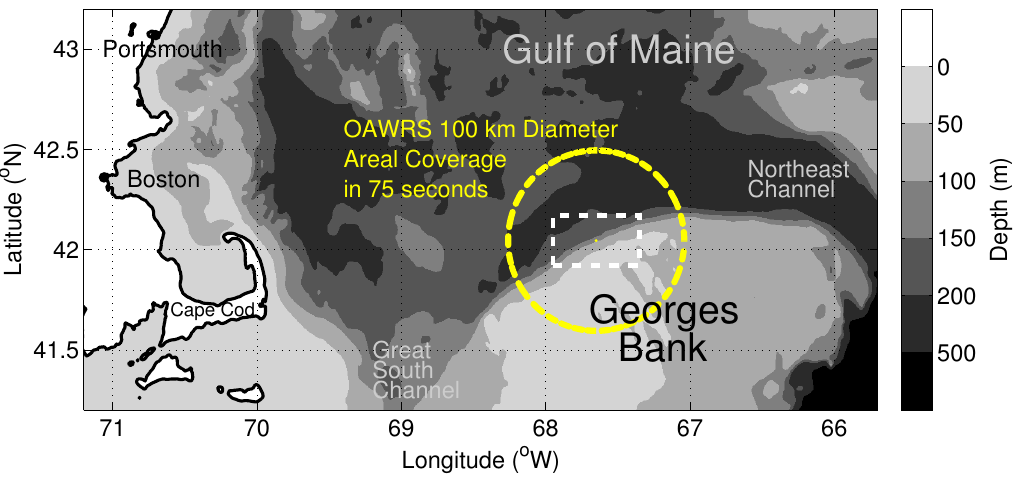
Figure 1. Location of the Ocean Acoustic Waveguide Remote Sensing (OAWRS) Gulf of Maine 2006 experiment. The yellow dashed circle shows 100-km diameter OAWRS areal coverage in 75 s. The white rectangular box represents the area investigated here. The gray scale shows the variation in the bathymetry in the